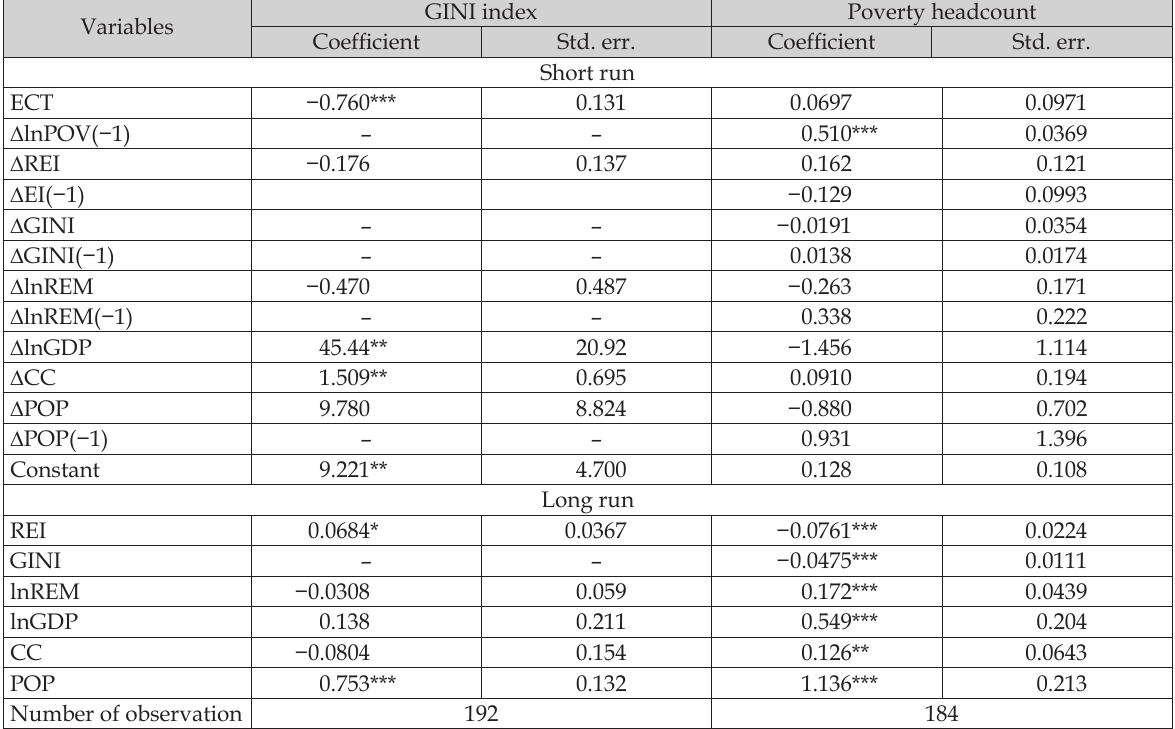
Table 8. PMG estimation